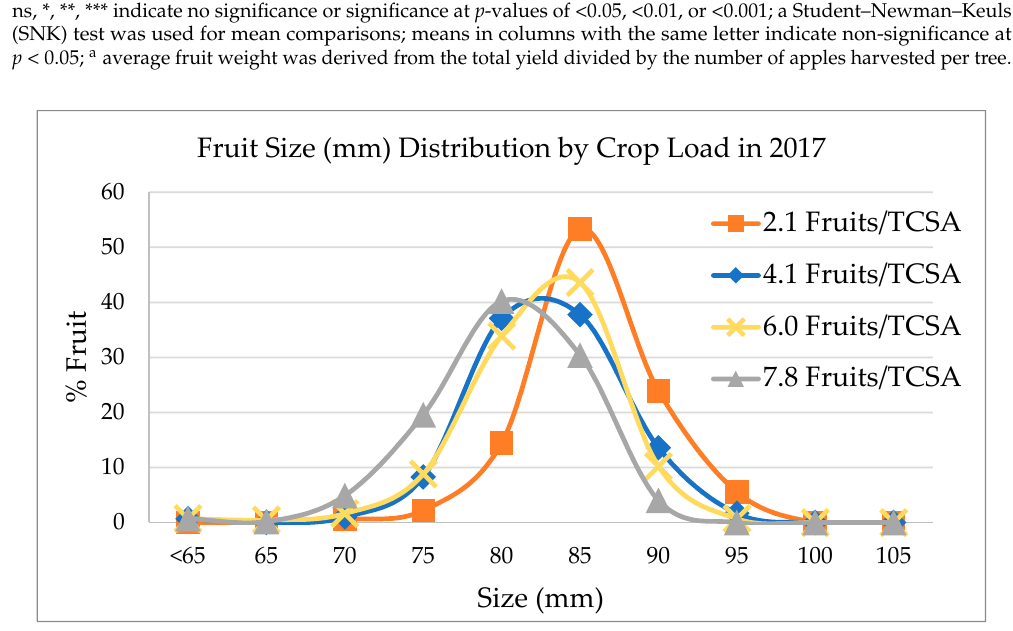
Figure 1. Distribution (% fruit) of fruit size (mm) by each crop load (2.1, 4.1, 6.0, 7.8 fruits/cm 2 ) level at harvest for “WA38” apples grown in Washington State, Wenatchee area in 2017. Table 2. The effects of induced crop load in 2017 on the number of apples/tree, yield (kg/tree), average fruit weight (g), and production (MT/ha) for “WA38” apples grown in Washington State, Wenatchee area in